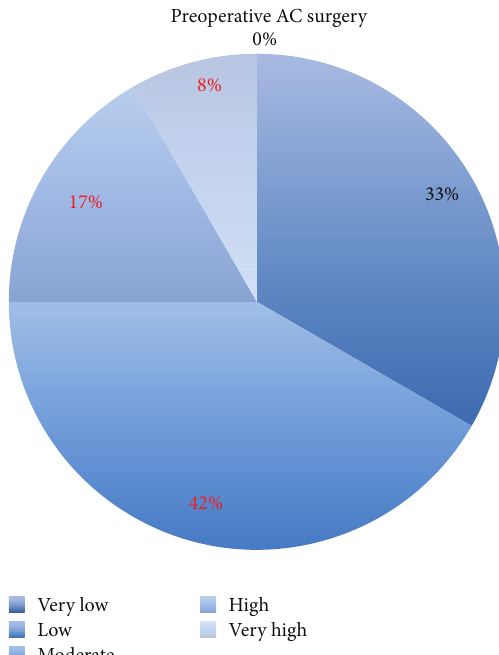
Figure3:Siliconeoilemulsificationdropletscounted4monthsafter oil injection into eyes preoperated on in the anterior chamber (AC) before retina service. Highlighted is moderate (42%) plus high (17%) plus very high (8%) emulsification rate = 67%.